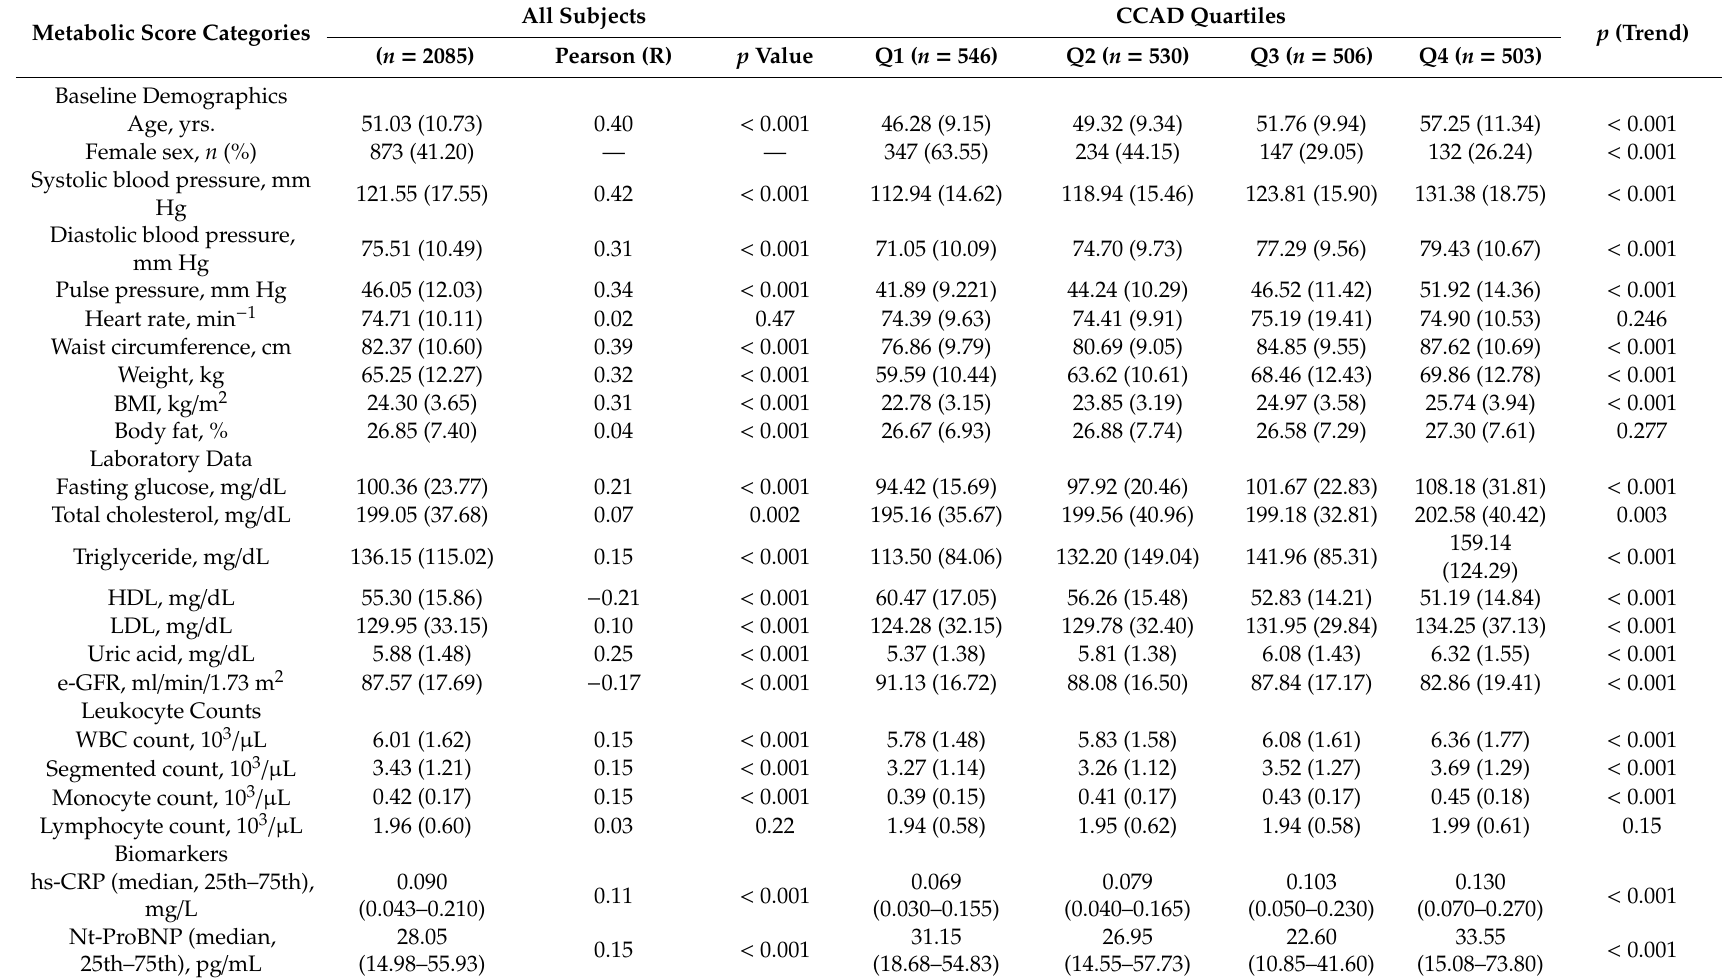
Table 1. Baseline demographics and cardiac structural information according to common carotid artery diameter (CCAD)